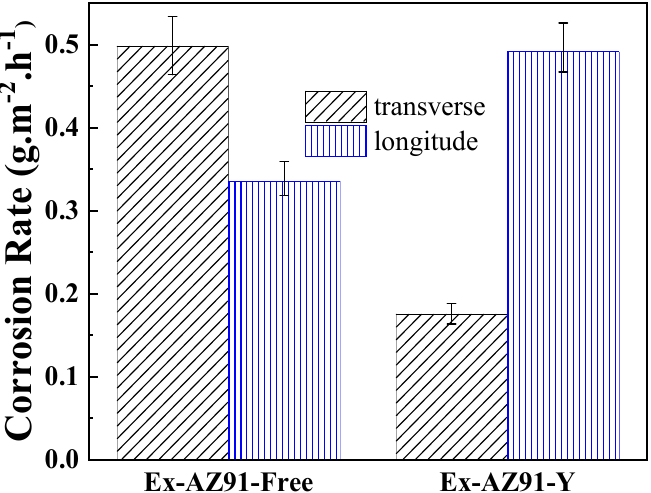
Figure 6. Corrosion rate of the transversal and longitudinal sections of Ex-AZ91-free and Ex-AZ91-Y alloy after immersed 12 h. alloy after immersed 12 h.